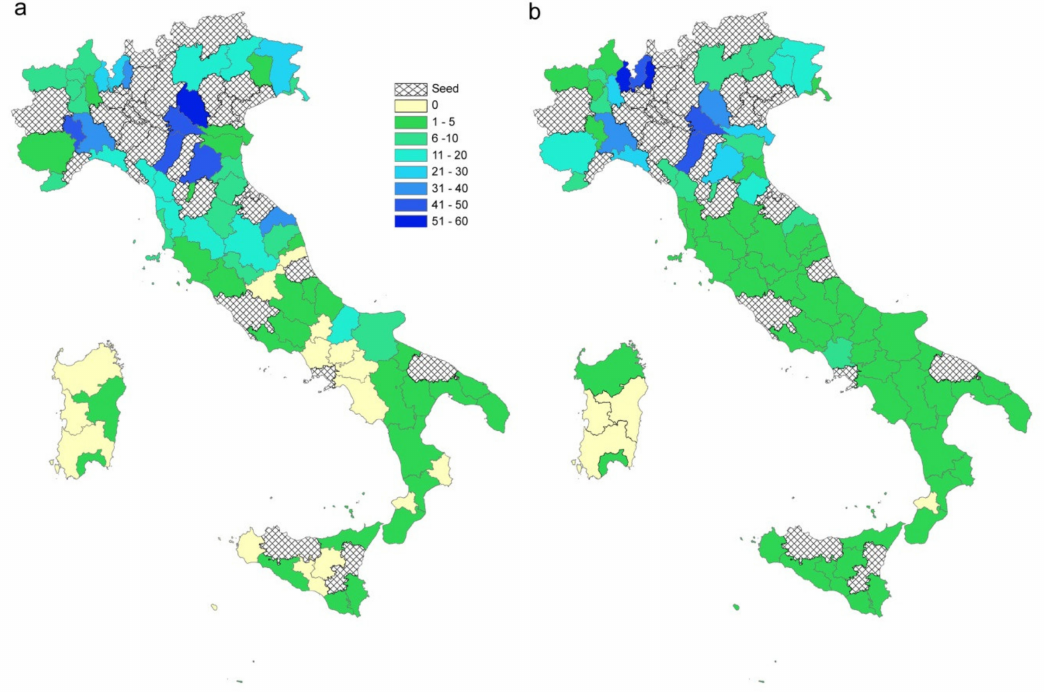
Figure 11. Results of the model. Comparison between observed ( a ) and estimated ( b ) infected people. The upper 95% confidence interval of the estimated infected people is used (when a province is turned into infected during the simulations the value of infected people is considered). Dashed provinces are the initial